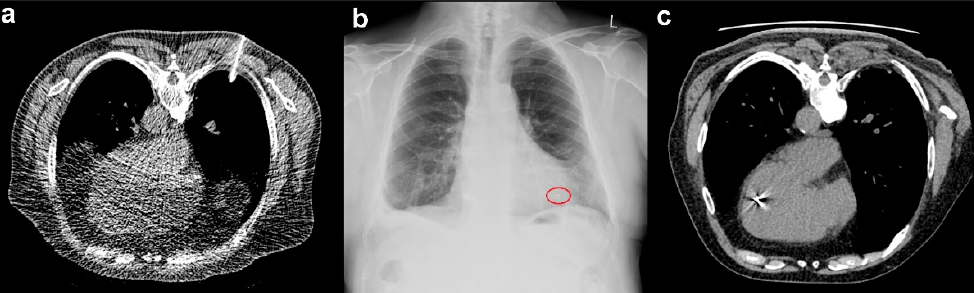
Figure 2. A representative case of marker migration. ( a ) Computed tomography (CT)-guided fiducial marker implantation is used to place a marker into a metastasis in the lower lobe of the right lung. ( b ) Radiography control with the projection of the marker to the heart. ( c ) The marker is shown after migrating to the left ventricle on the day of insertion. There has been no change in the marker position after two years.